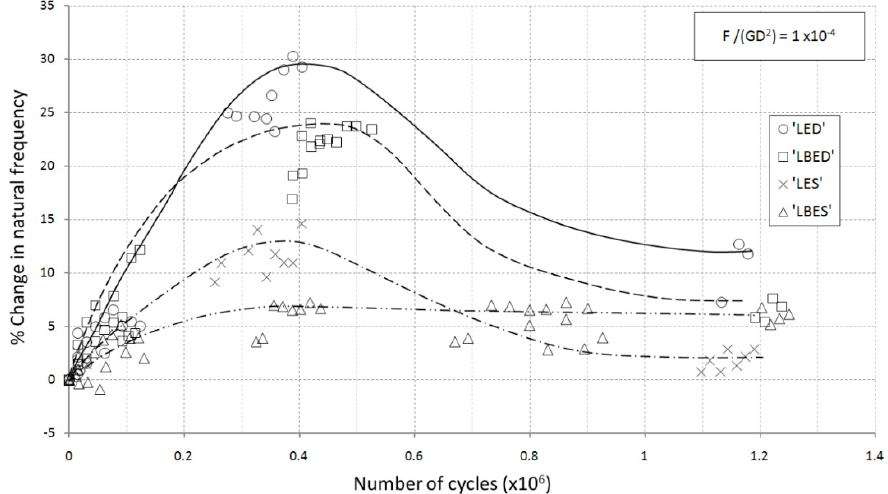
Figure 24. Long-term change in natural frequency of a tetrapod foundation (Figures 9 and 14d) for different ground profiles indicated by LED, LBED, LES, and LBES.